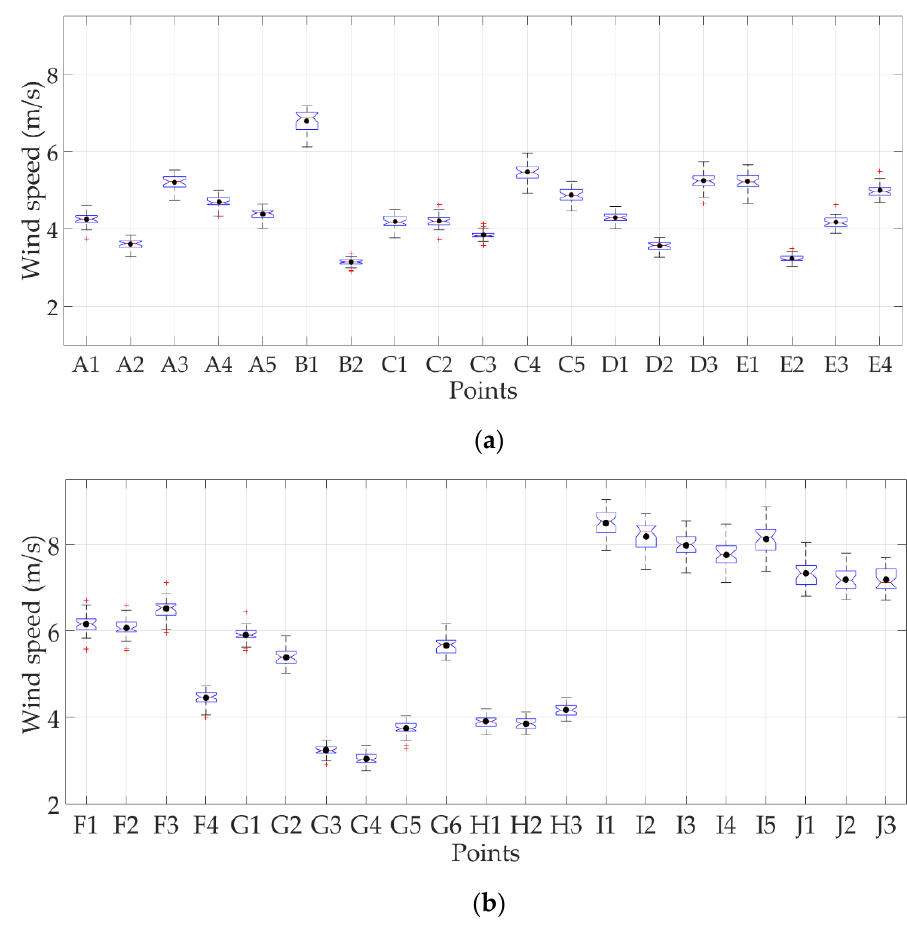
Figure 3. Assessment of the yearly mean wind speed corresponding to the 35-year time slice resulting from processing the ECMWF ERA-Interim data. Each box includes several keys: the top and the bottom of the box represent the upper and lower quartiles, so the box spans the interquartile range; the median is marked by a vertical red line placed inside of the box; the whiskers are the lines (two) outside the box that extend to the highest (upper extreme) and lowest (lower extreme) observations; the outliers are those observations that are numerically distant from the rest of the data (red crosses); the mean values are represented by black dots; ( a ) Reference points A–E; ( b ) Reference points